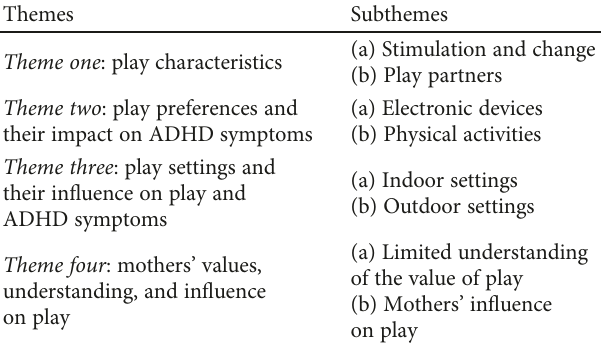
Table 3: Emerged themes.